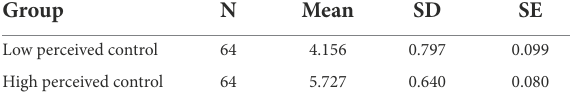
TABLE 3 Manipulation check results for perceived